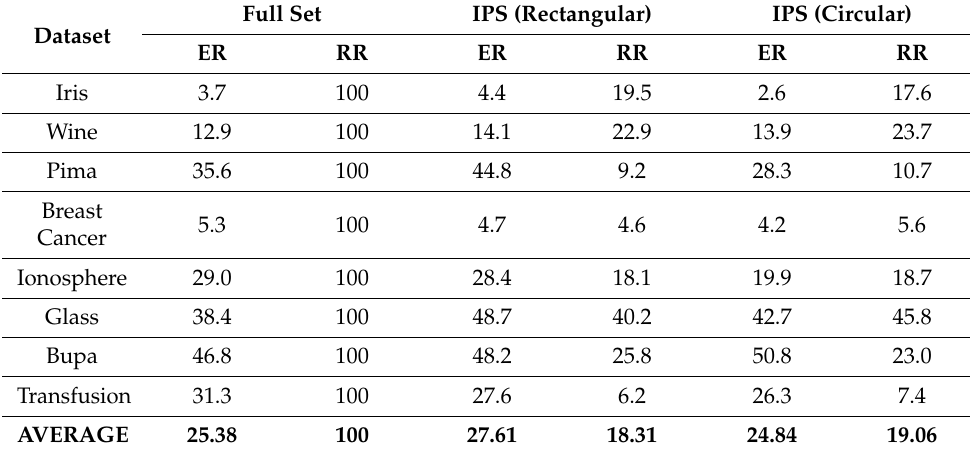
Table 2. Results of the experiments with the Incremental Prototype